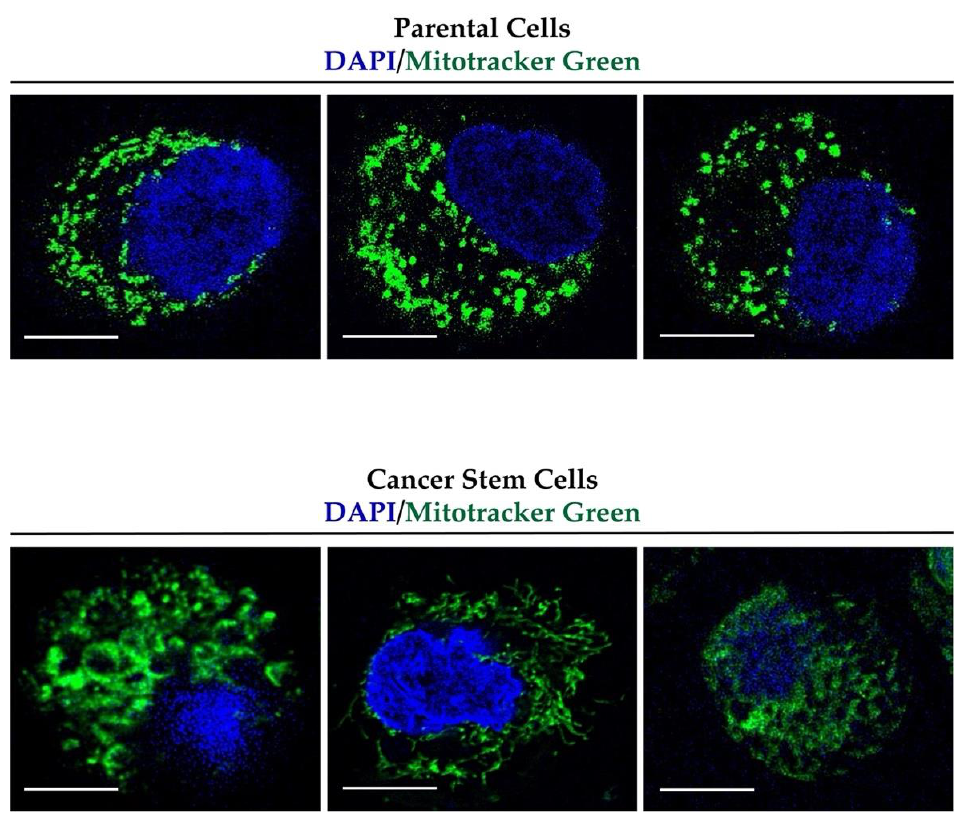
Figure 2. Panc1 CSCs show elongated mitochondria. Representative confocal images of the mito- chondria stained with MitoTracker green (green signal) and nucleus stained with DAPI (blue signal) in the parental cells and cancer stem cells at 63× magnification. Scale bar: 10 µm.